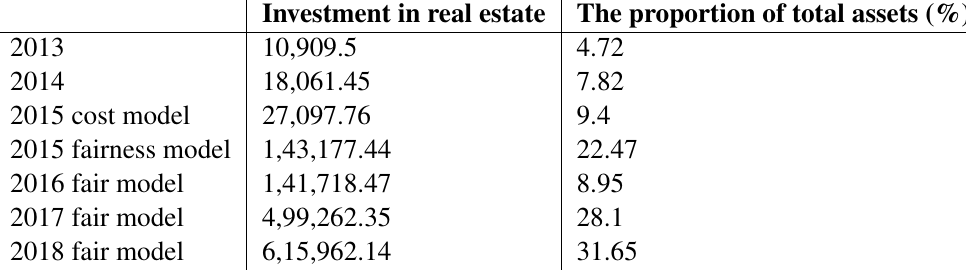
Table 1 Overview of A Commercial Investment Real Estate from 2013 to 2018 (Unit: 10,000